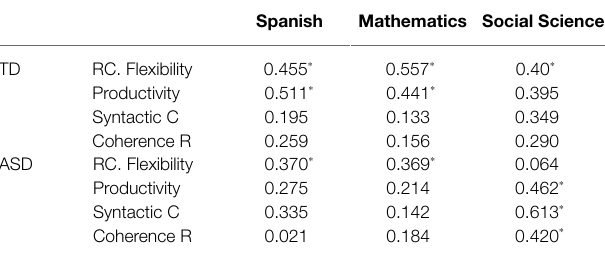
TABLE 4 | Partial correlations between reading/writing skill and academic